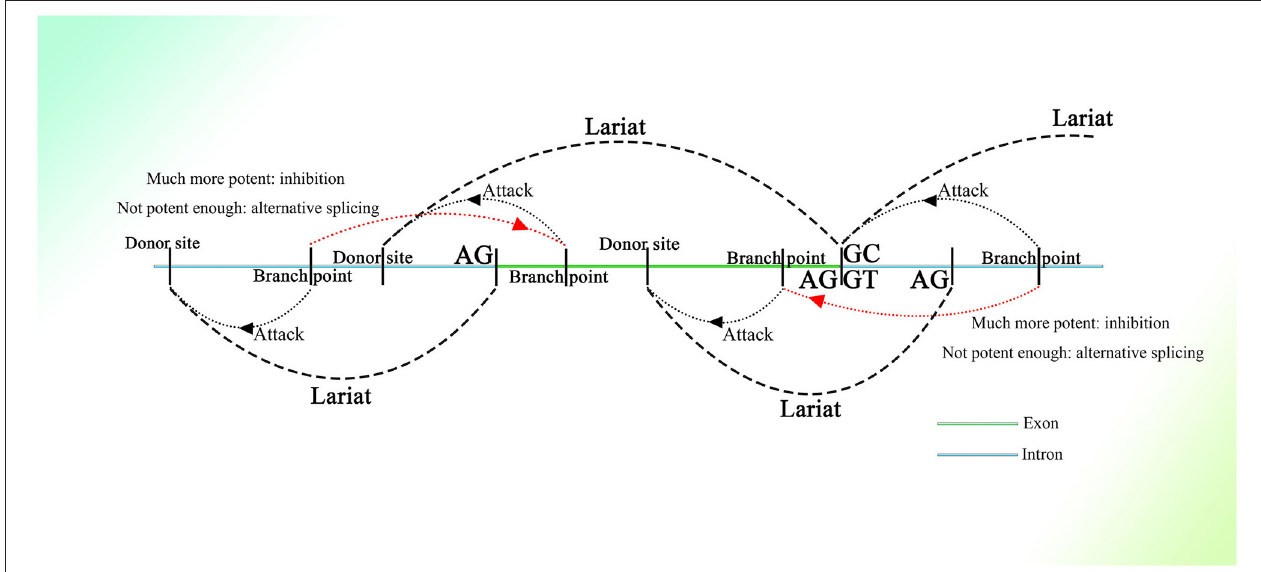
FIGURE 1 | Schematic diagram of the generation of partially overlapping lariats. The branch points and donor sites are distributed on the genome. The branch points close to the exon are much more potent than those closest to or on the exon ordinarily, which leads to the excision of the exon, whereas if they are not potent enough, the exon will be excised as alternative splicing. Because the exon-containing lariat also has part of an intron within it, mRNA with the exon sequence only is not able to be spliced because of the loss of the